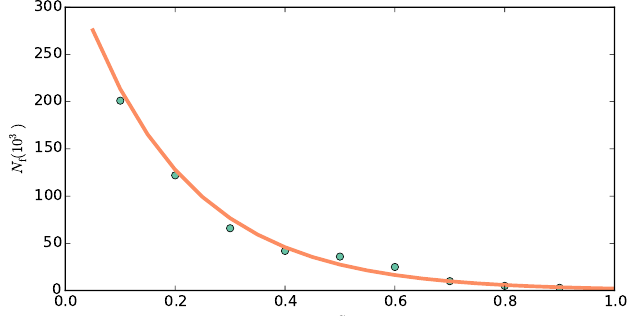
Figure 11. S-N curve obtained by numerical